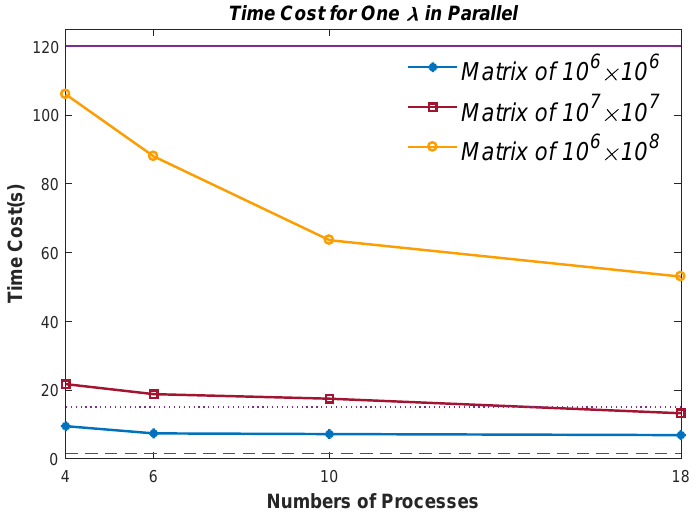
Figure 7. Computing one λ in